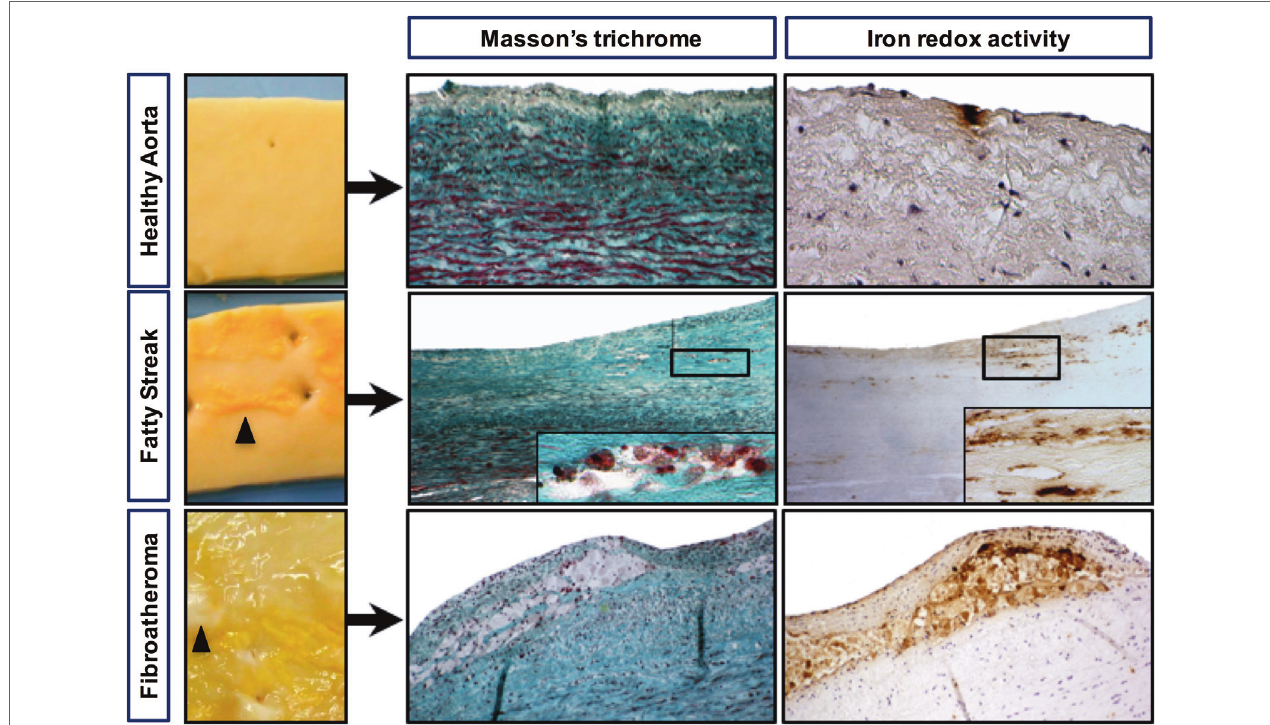
FigUre 1 | Iron deposits are frequently detected in early-stage atheroma lesions. Macroscopic pictures of a healthy aorta (smooth luminal interface), a fatty streak with subendothelial yellow deposits (black arrowheads) and a fibroatheroma with yellow deposits covered with a white capsule, forming initial plaques (black arrowheads). Visualization of foam cells was accomplished by Masson’s trichrome staining, and redox-active iron was visualized by Perls reaction followed by DiAminoBenzidin (DAB) polymerization (see materials and methods). Perls staining alone and DAB alone were strictly negative (not